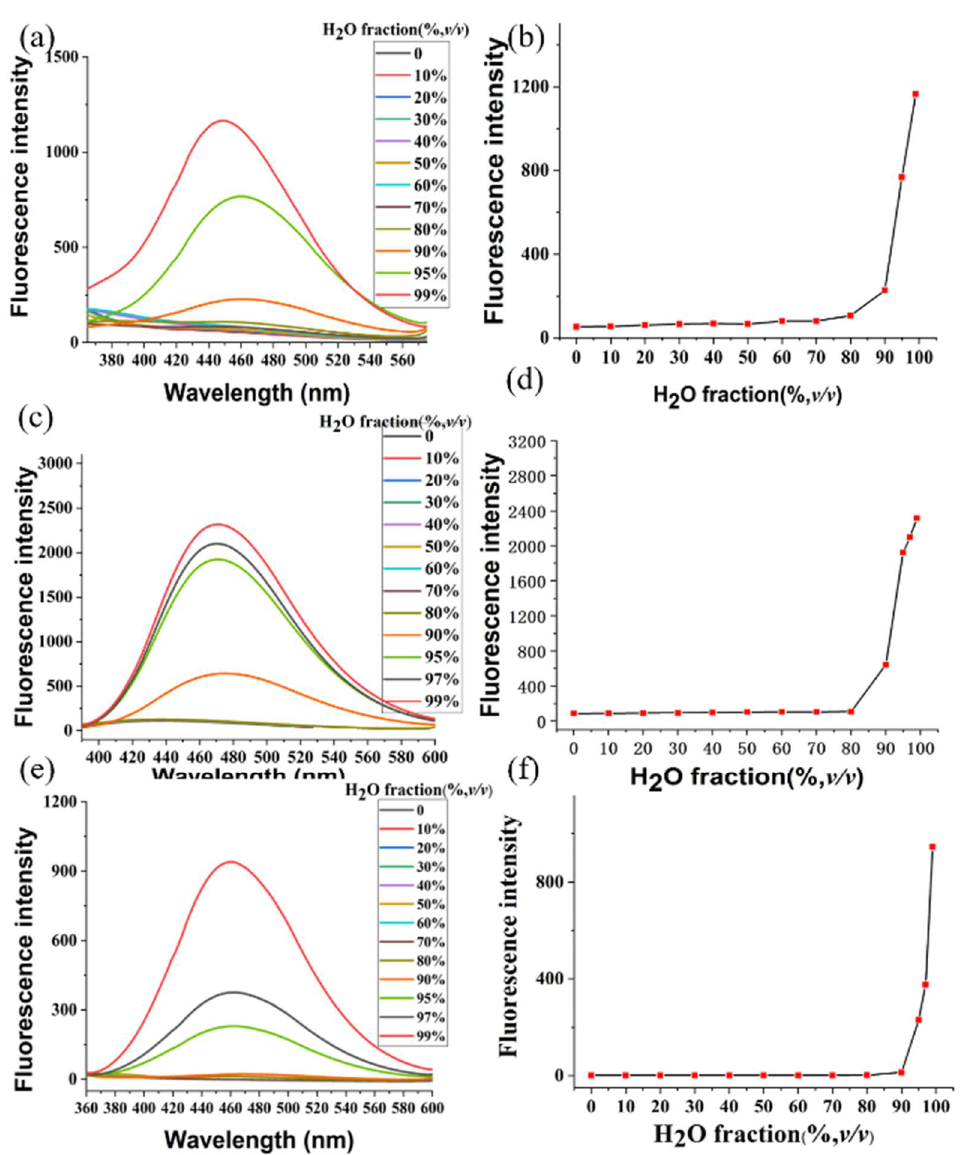
Figure 2. Fluorescence spectra of DMP[5]-TPE ( a , b ) , PCP[5]-TPE ( c , d ) and TPE ( e , f ) in different THF/H 2 O mixed solutions. (Dilute solutions of 1 × 10 −5 mol/L DMP[5]-TPE , PCP[5]-TPE and TPE in THF excitation at 300 nm).